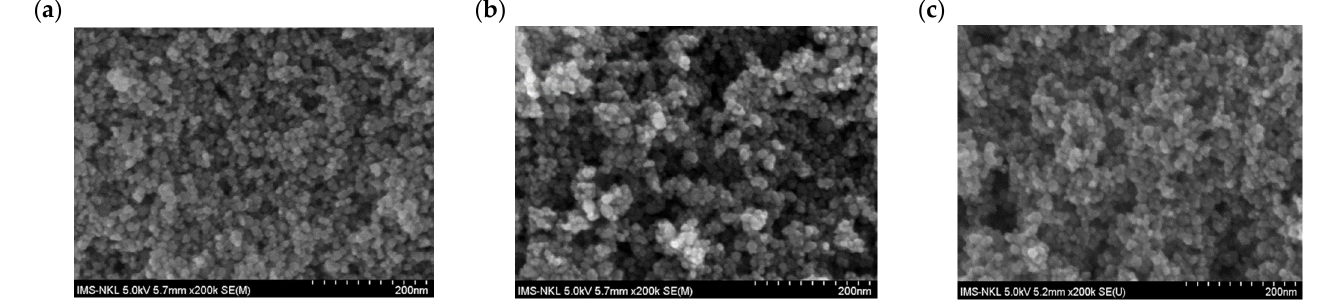
Figure 3. SEM images of SPIONs recorded at pH ( a ) 9.5, ( b ) 10.09, and ( c ) 11.1.